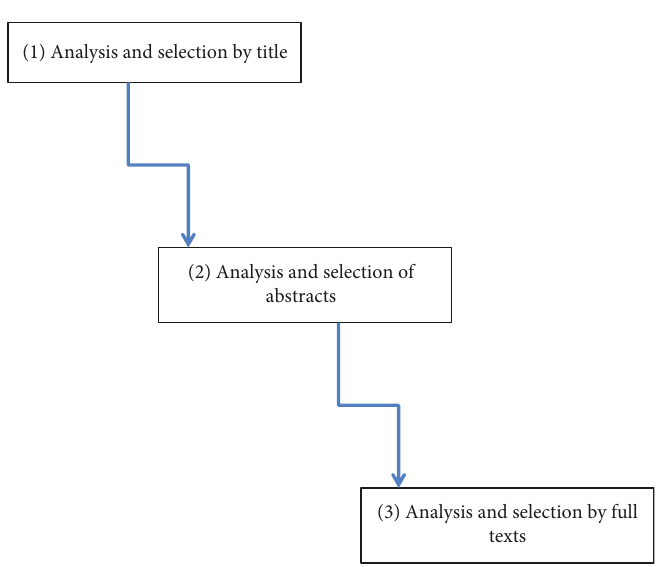
Figure 1: The selection process hierarchically included the following